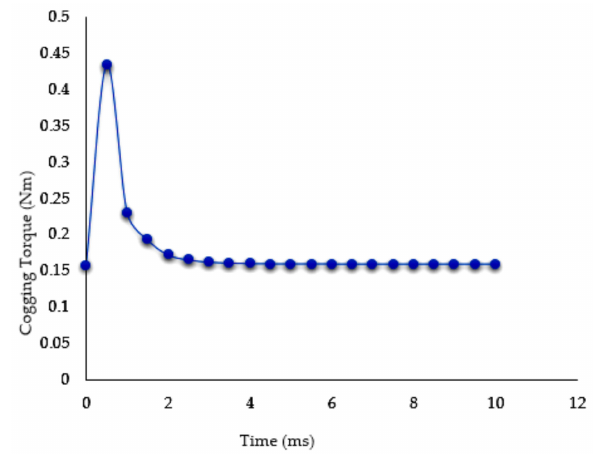
Figure 18. Transient response of cogging torque.